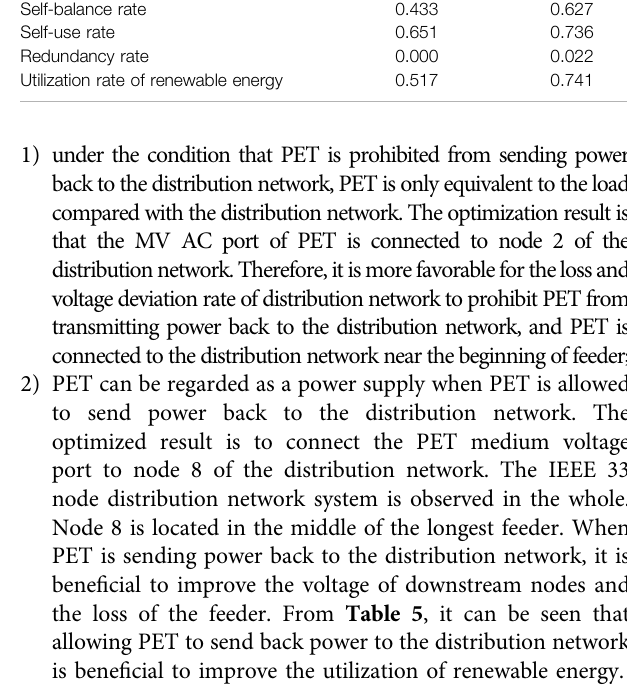
TABLE 5| Index comparison forwhetherthe10 kVACport reverses thepower of the power grid or not. Category No power can Node